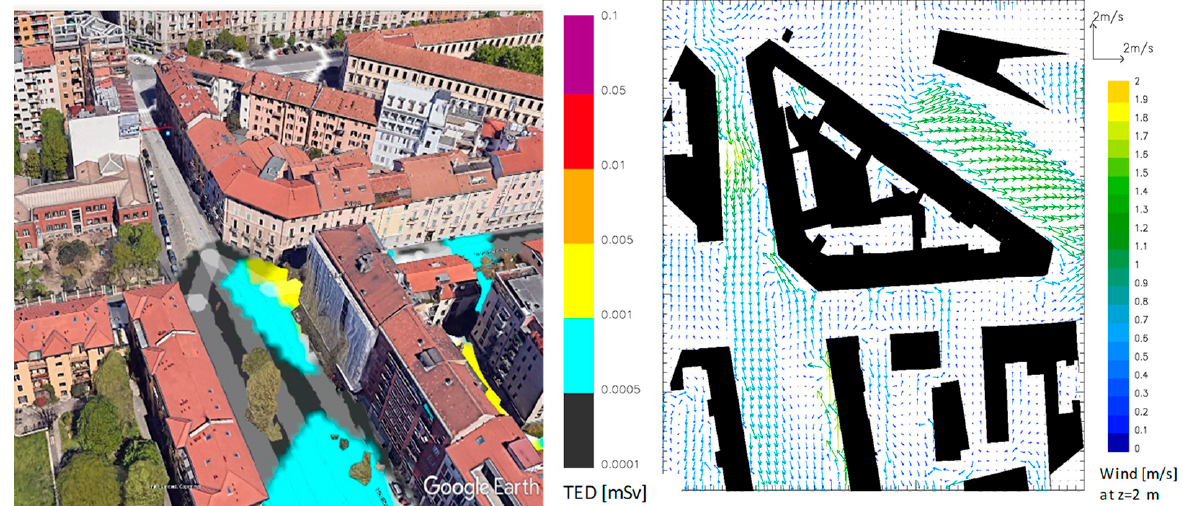
Figure 3. 3D representation of the contamination of the area and 2D scheme reporting wind turbulence around the same building at a level between 0 and 2 m above the ground.